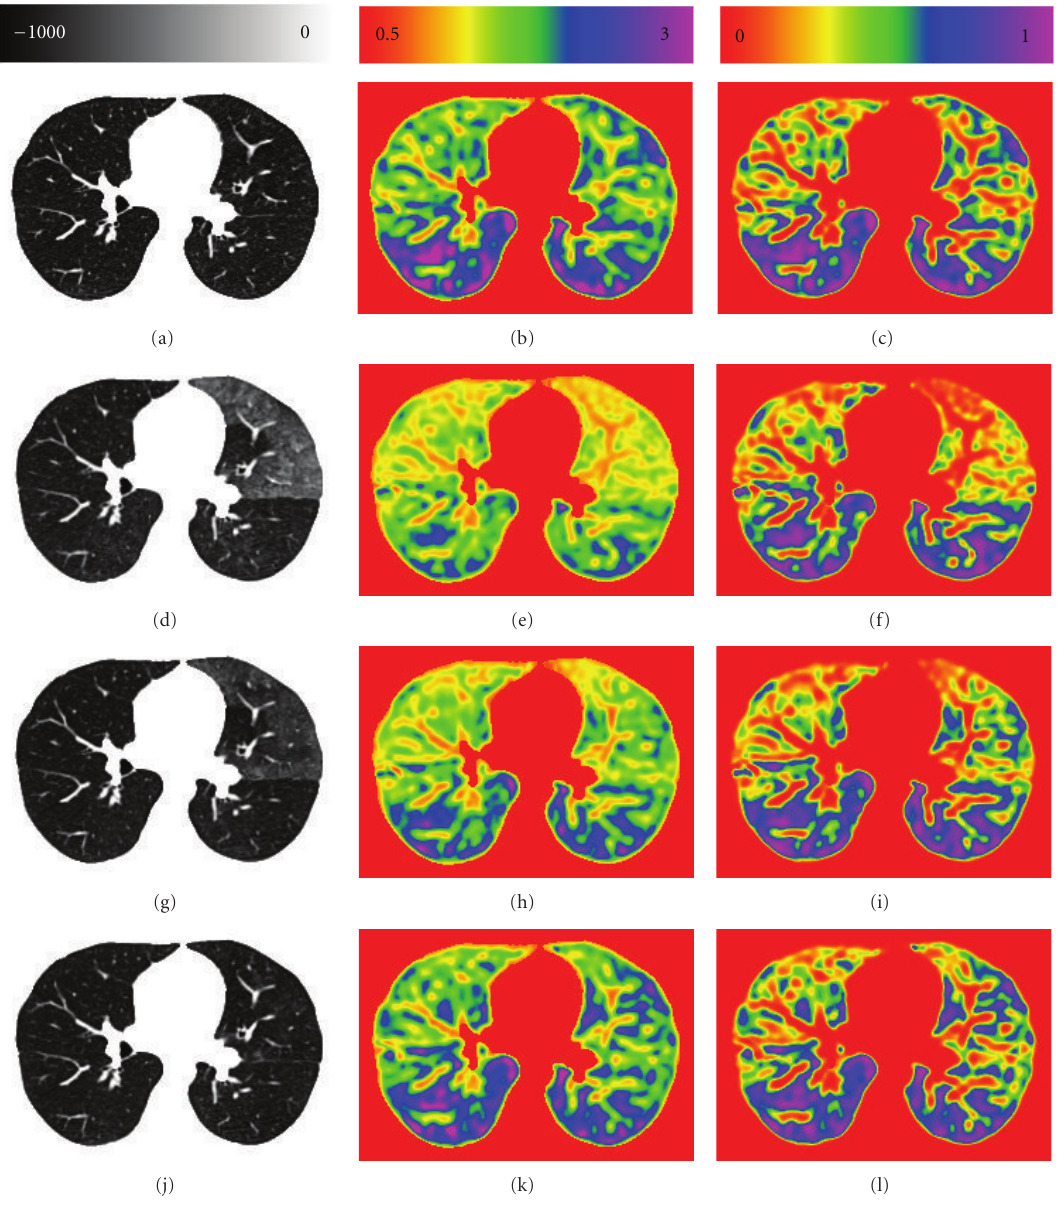
Figure 12: Comparison of local lung function estimates over di ff erent phases. (a), (d), (g), and (j) show the intensity pattern on the same slice from baseTLC, deformed post0TLC to baseTLC, deformed post4TLC to baseTLC, and deformed post24TLC to baseTLC, respectively. (b), (e), (h), and (k) show the Jacobian maps estimated from four phases on the slice. (c), (f), (i), and (l) show the corresponding rank maps of Jacobian